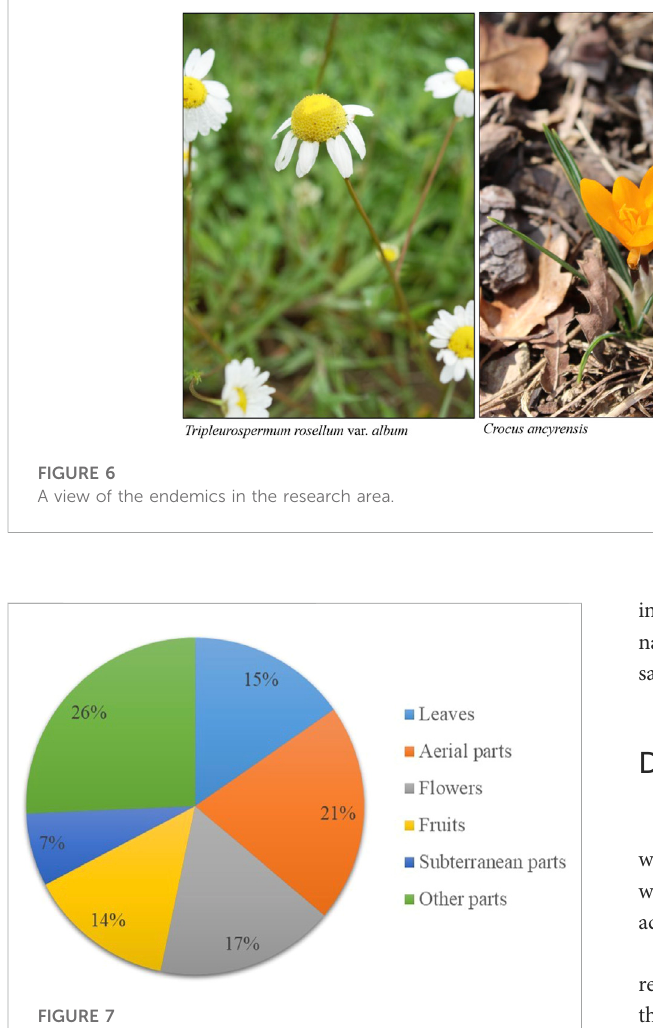
FIGURE 7 Used parts of the medicinal plants in the